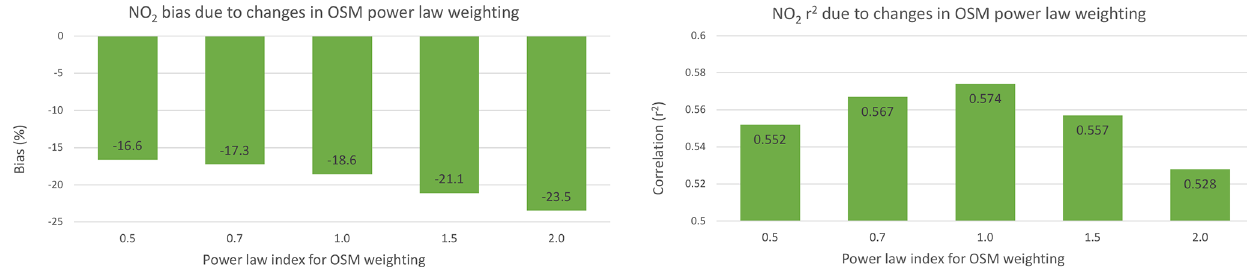
Figure 13. Change in bias and spatial correlation (coefficient of determination r 2 ) for NO 2 as a result of changes in the power-law index applied to the OSM road traffic weighting. Lower power-law indices give more weight to minor roads, and higher power-law indices give more weight to major roads. The results are based on the European calculations, and all available AIRBASE stations are included.